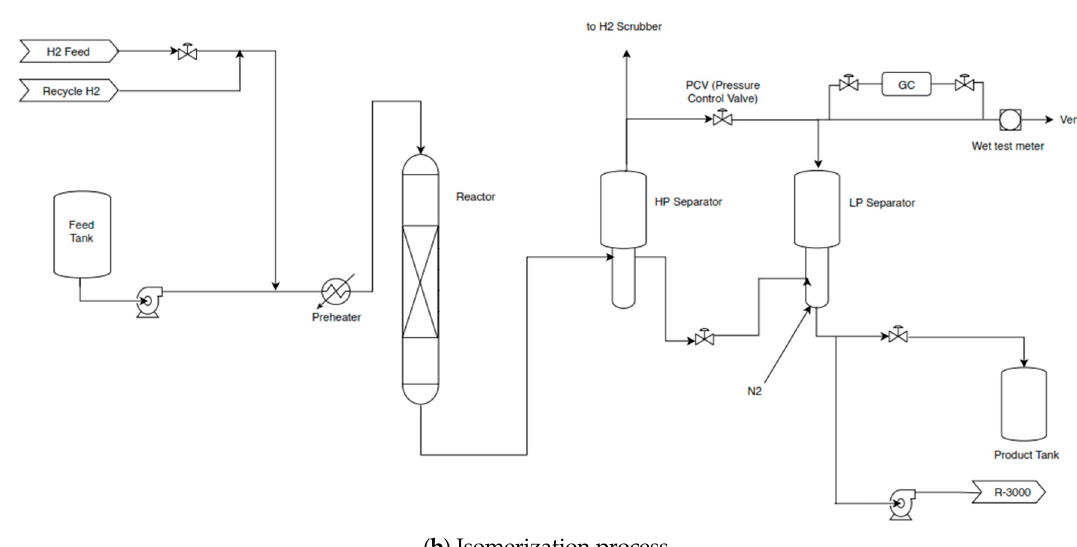
Figure 2. Production pathway for producing MBJ consisting two main steps: ( a ) dehydrogenation process and ( b ) isomerization process.